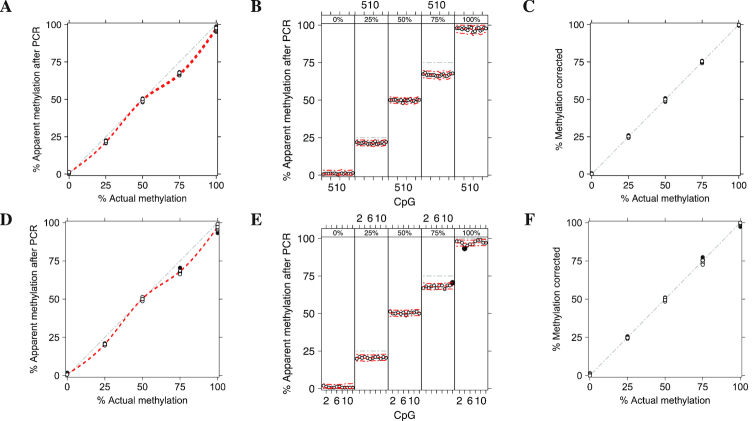
Methylation level of two independent assays KCNQ1OT1 (top panels) and H19/IGF2 (bottom panels) calibrated by MethylCal with model \documentclass[12pt]{minimal}
\usepackage{amsmath}
\usepackage{wasysym}
\usepackage{amsfonts}
\usepackage{amssymb}
\usepackage{amsbsy}
\usepackage{upgreek}
\usepackage{mathrsfs}
\setlength{\oddsidemargin}{-69pt}
\begin{document}
}{}$\mathcal {M}_{4}$\end{document} and \documentclass[12pt]{minimal}
\usepackage{amsmath}
\usepackage{wasysym}
\usepackage{amsfonts}
\usepackage{amssymb}
\usepackage{amsbsy}
\usepackage{upgreek}
\usepackage{mathrsfs}
\setlength{\oddsidemargin}{-69pt}
\begin{document}
}{}$\mathcal {M}_{3}$\end{document} selected by the DIC, respectively. (A–D) The apparent level of methylation observed after amplification (y-axis) is plotted as a function of the actual methylation percentage (AMP) (x-axis). Circles depict the apparent level of methylation after PCR for each CpG at different AMPs, whereas the red dotted lines show MethylCal’s predicted level of methylation for each CpG. Black dots highlight potential outliers. The grey dash-dotted line represents an unbiased plot. (B–E) The apparent level of methylation observed after amplification (y-axis) is plotted (circles) as a function of the CpGs in the DMR (x-axis), stratified by AMP (top figure box and the grey dot-dashed line). For each stratum, the red dotted line shows the level of methylation predicted by MethylCal, whereas the red dot-dashed lines depict the 95% prediction credible interval. (C–F) The result of PCR-bias correction obtained by using MethylCal. The corrected methylation degree (y-axis) is plotted as a function of the AMP (x-axis). The grey dash-dotted line represents a unbiased corrected plot.